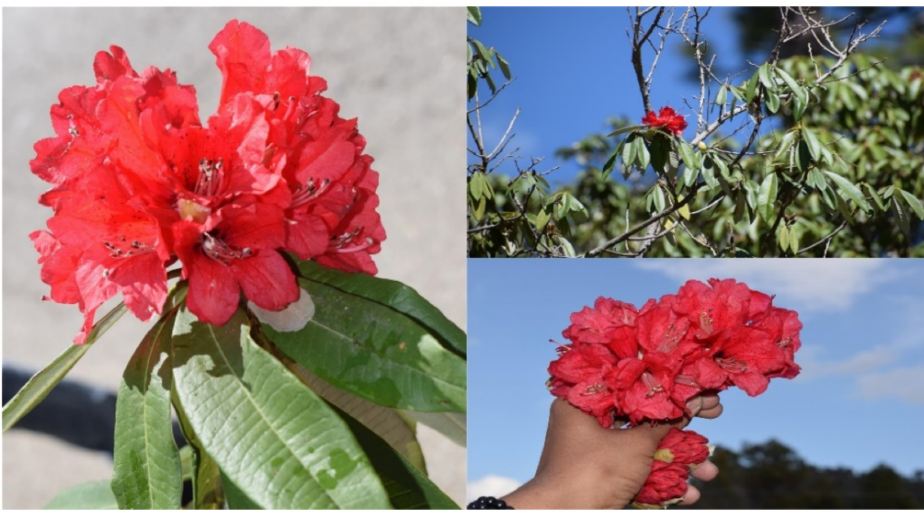
Figure 2. Field photographs of Rhododendron